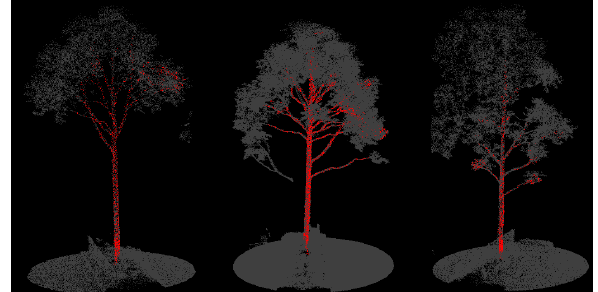
Figure 10. Classification of Woody Structure